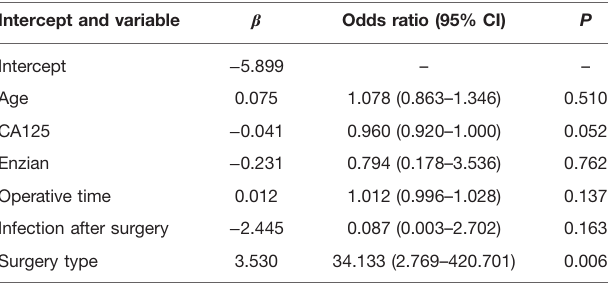
TABLE 4 | Predictors for recurrence after conservative surgery of intestinal deep endometriosis. Intercept and variable